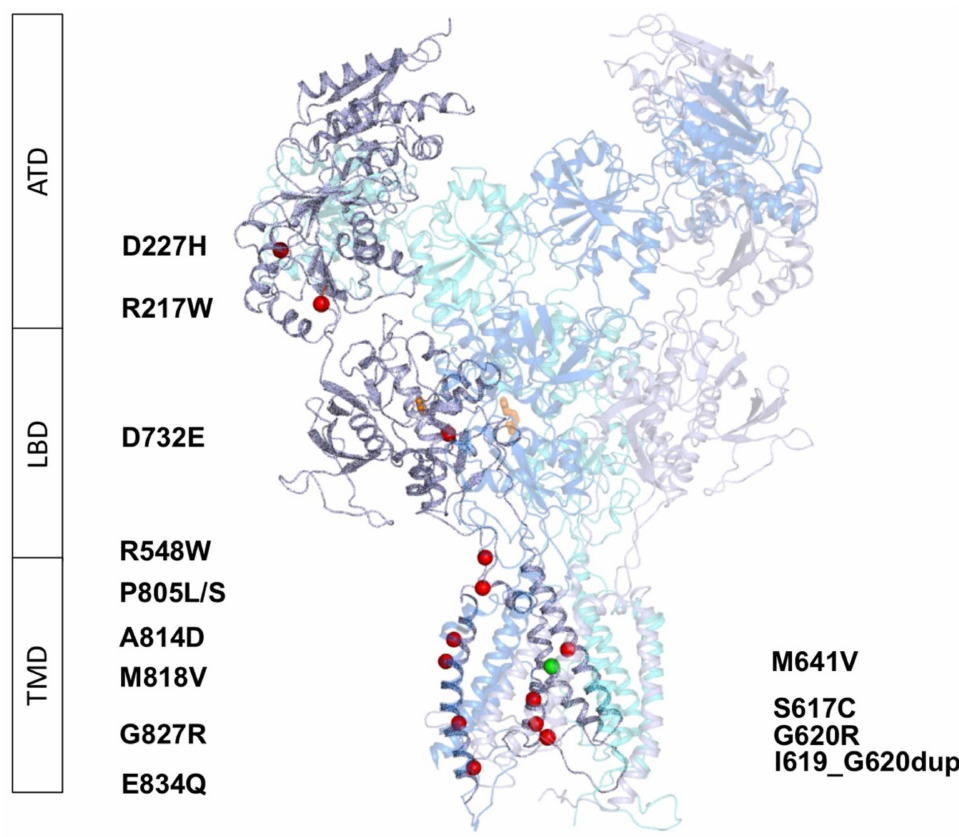
Figure 1. Distribution of de novo GRIN1 variants along GluN1 subunit domains and NMDAR struc- ture, composed of two GluN1 (in grey and purple), one GluN2A (cyan), and one GluN2B (blue) sub- units. Variants are shown as red spheres, agonist and coagonists in orange and Mg 2+ as a green sphere. ATD: Amino Terminal Domain, LBD: Ligand Binding Domain, TMD: Transmembrane